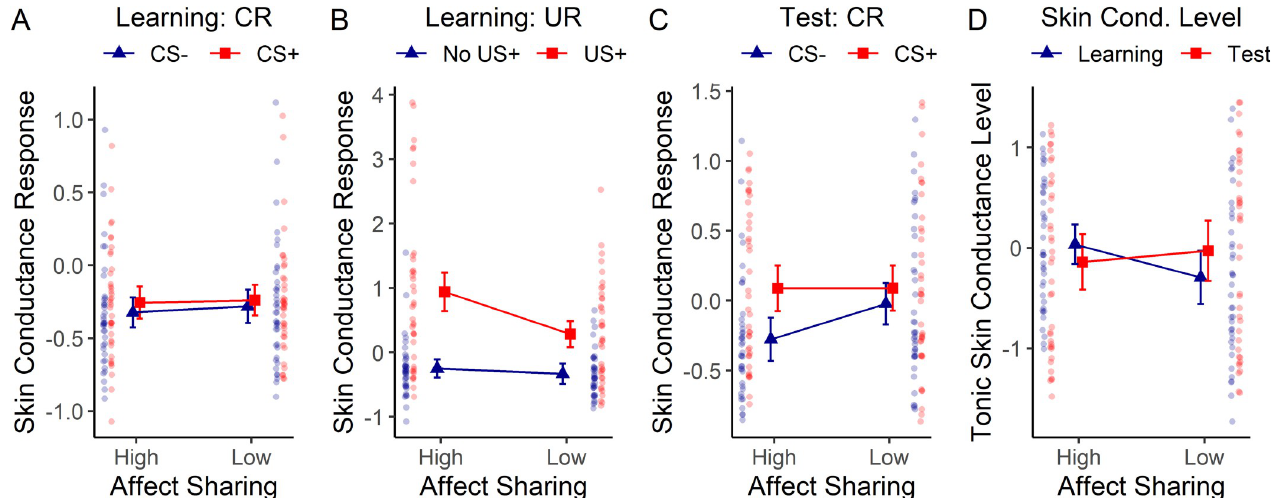
Fig 2. Effects of hypnotic suggestions for high versus low affect sharing on skin conductance response (SCR) in the learning (A, B) and test stage (C) and on tonic skin conductance level (SCL) across both stages (D), expressed as z-scores. A) SCR to seeing the colored square (CS+ or CS-) in the learning stage. B) SCR to seeing the demonstrator receive shocks (US) or no shocks (US absence) in the learning stage. The difference in responses to US and US absence indicates the unconditioned response. C) SCR to seeing the colored square (CS+ or CS-) in the test stage. The difference in responses to CS+ and CS- indicates the conditioned response. D) Tonic skin conductance level (SCL) observed in the learning and test stage. Error bars reflect 95% confidence intervals corrected for within-subject designs (see Methods). Results of individual participants are shown laterally as semi-transparent